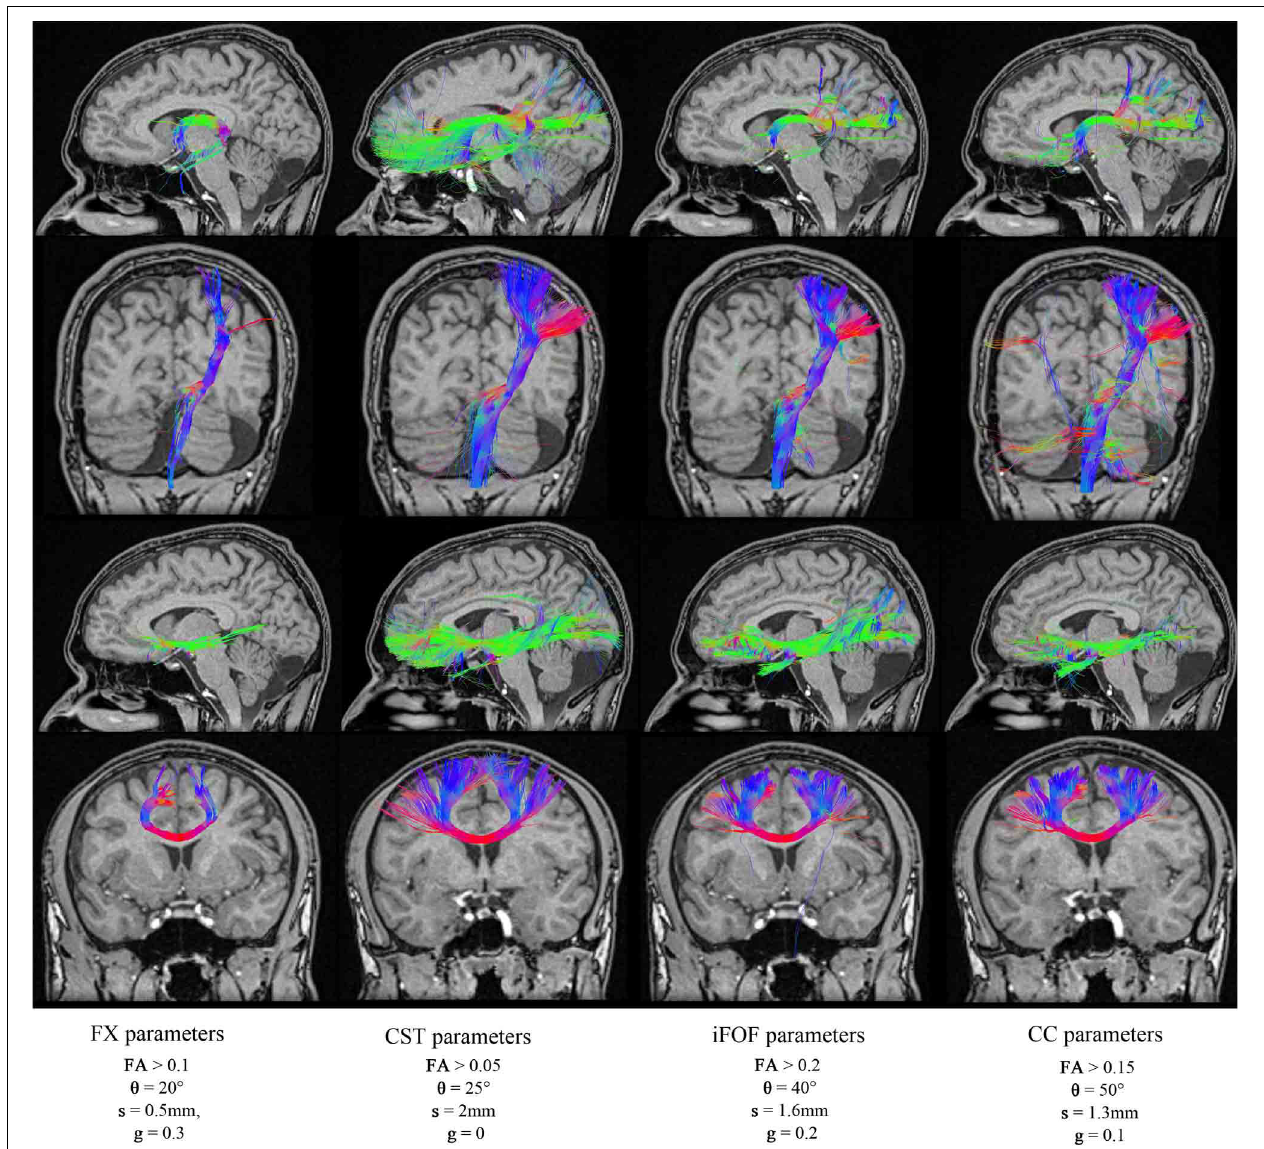
FIGURE 7 | Reconstructions of four different fiber bundles (FX, CST, iFOF, CC) using a mixture of parameters. Some of these parameters are best suited for long bundles (CST, iFOF), while others parameters favors the reconstruction of curved fibers. (HC